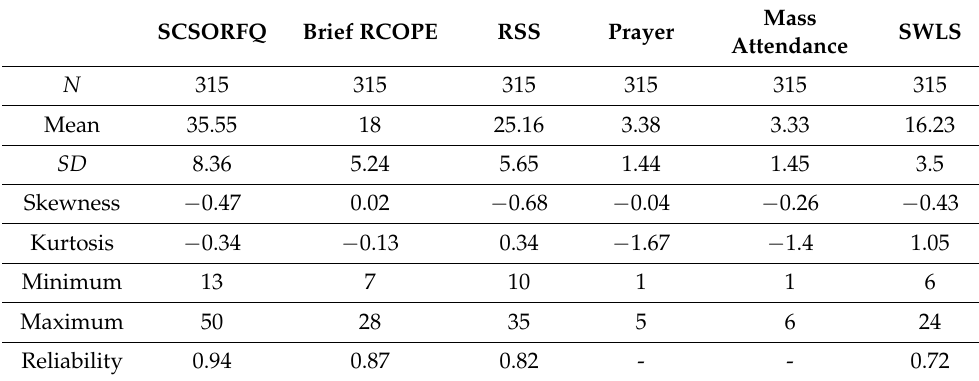
Table 1. Descriptive statistics for the study variables.